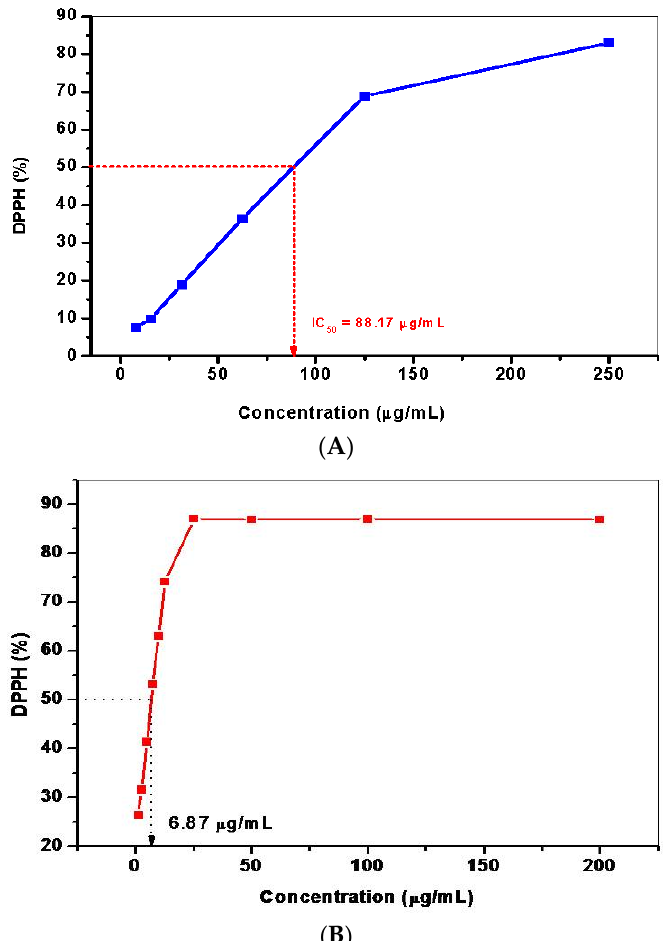
Figure 10. 2,2-Diphenyl-1-picryl-hydrazyl (DPPH) radical scavenging activity and IC 50 of the methanol extract of H. persicum ( A ) and ascorbic acid ( B ).